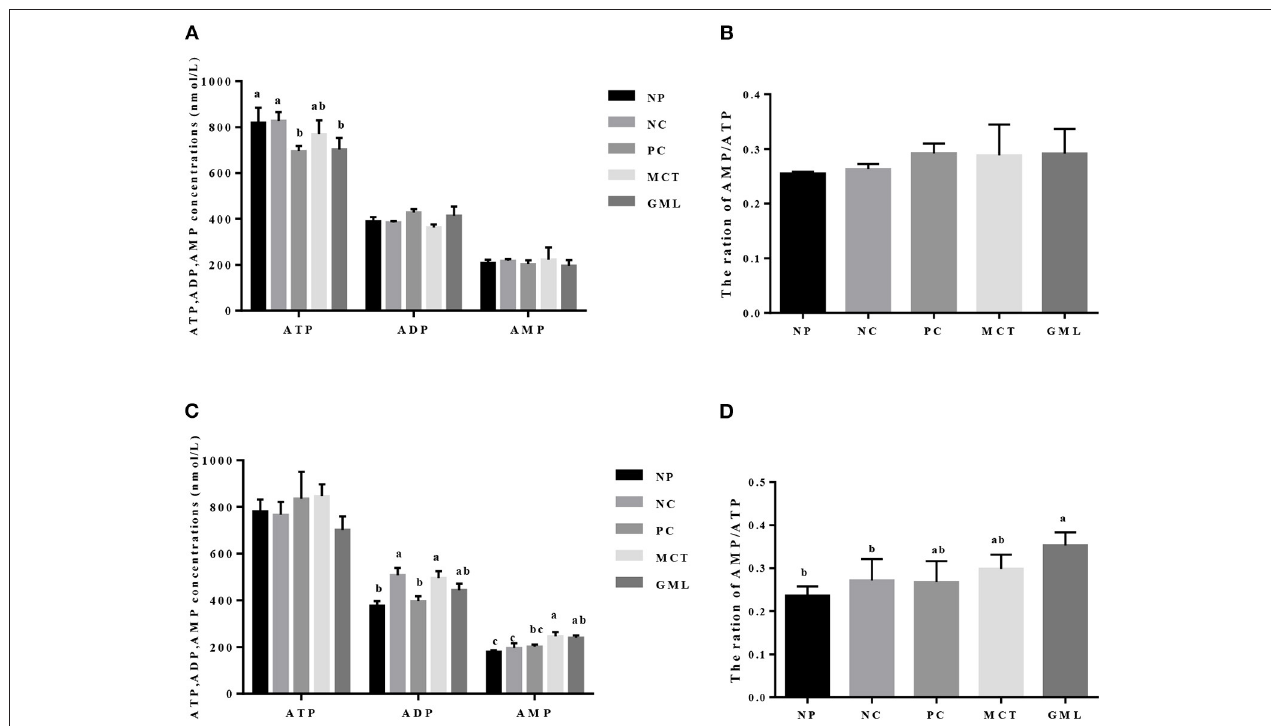
FIGURE 4 | The energy level in the jejunal mucosa (A,B) and ileal (C,D) mucosa. a − c Mean values sharing different superscripts within a row differ ( P < 0.05). Values are the mean ± SEM, n = 6 per group. NP, normal protein basal diet no antibiotics included; NC, low-protein basal diet no antibiotics included; PC, low-protein basal diet + antibiotics (75 mg/kg quinocetone, 20 mg/kg virginiamycin and 50 mg/kg aureomycin); MCT, low-protein basal diet + 2 kg/T tricaprylin/tricaprin; GML, low-protein basal diet + 2 kg/T glycerol